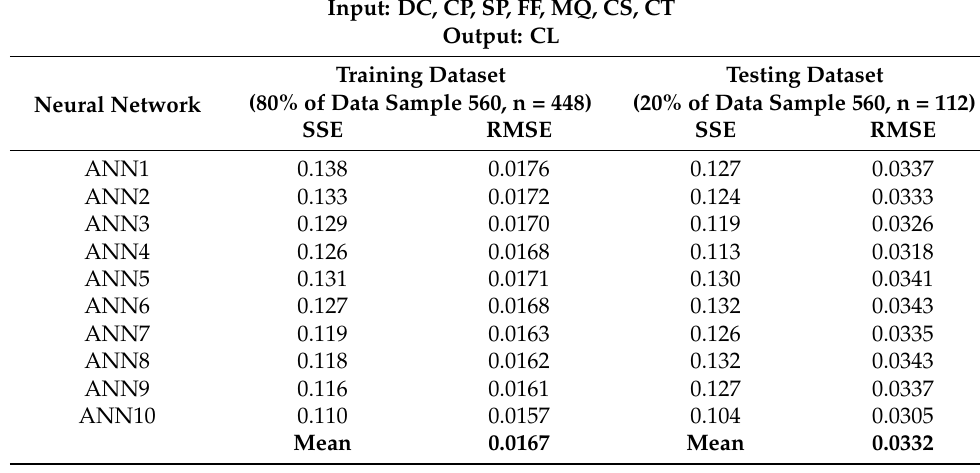
Table 9. RMSE values for the ANN model.